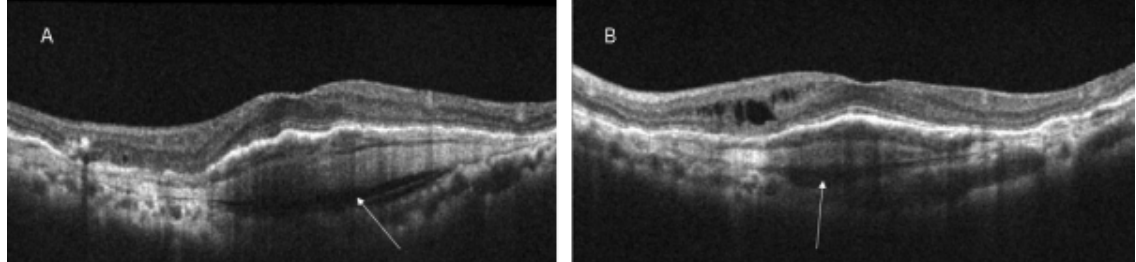
Figure 2: The radial scans of the structural OCT of the right eye (A) and the left eye (B), performed on the SSOCTA machine show a slightly elevated subretinal lesion with the typical appearance of horizontal hyper- and hyporeflective laminae suggestive of a multilayered PED. A hyporeflective space is seen just below that, marked by an arrow which represents the choroidal cleft. The retina appears almost compact with a few intraretinal fluid spaces in the left eye (B). This patient had received just 2 intravitreal anti-VEGF injections in each eye.